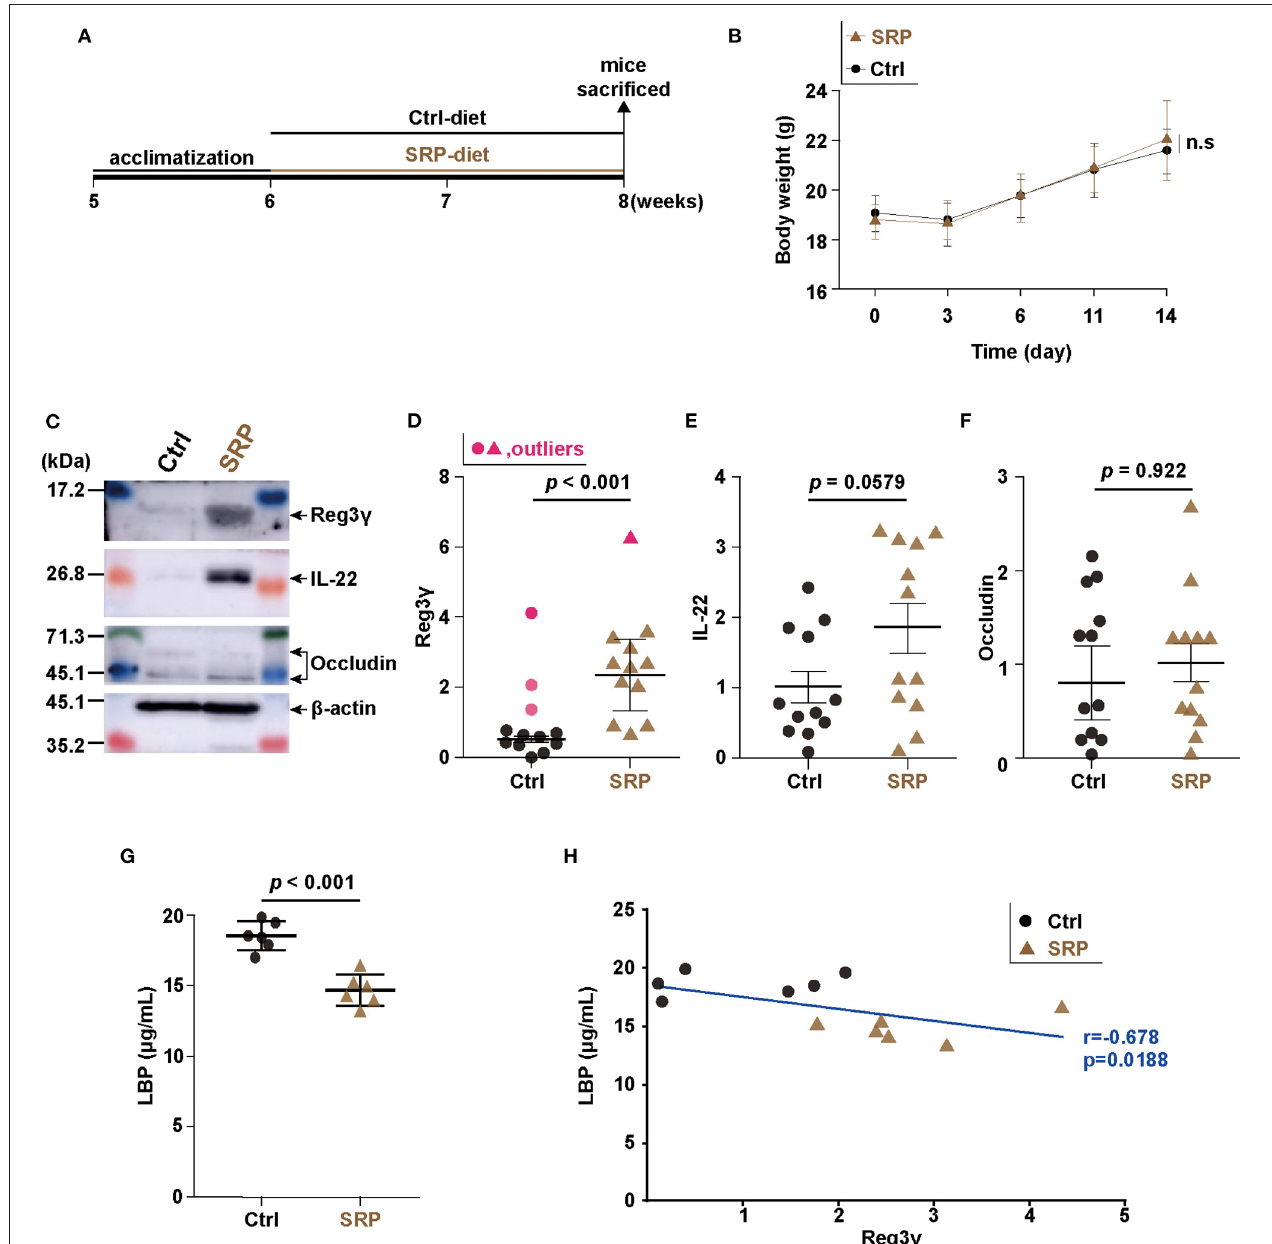
FIGURE 1 | Changes in intestinal barrier function due to soybean resistant protein (SRP)-diet intake. Schedule for the experiment examining the effects of ad libitum feeding of the SRP-diet or the control diet (A) . The mice were weighed every 3–5 days during the experimental period (B) . Representative western blots (C) and densitometory analyses (D–F) . The expression of Reg3 γ (D) , IL-22 (E) , and occludin (F) in cecal tissue was assessed by western blotting [ n = 9–12; values are expressed as the mean (SD)]. The LBP concentration was measured by ELISA [ G ; n = 6; values are expressed as the mean (SD)]. The correlation between the production of Reg3 γ and LBP ( H ; n = 6). The correlation was assessed by Pearson’s correlation coefficient. p indicates the p -value. Statistical analysis was performed after the omission of outliers. Ctrl, control diet group; n.s, not significant; SRP, soybean resistant protein diet group; LBP, lipopolysaccharide-binding protein; Reg3 γ , regenerating islet-derived protein 3 gamma; IL-22, interleukin 22; SD, standard deviation; ELISA, enzyme-linked immunosorbent